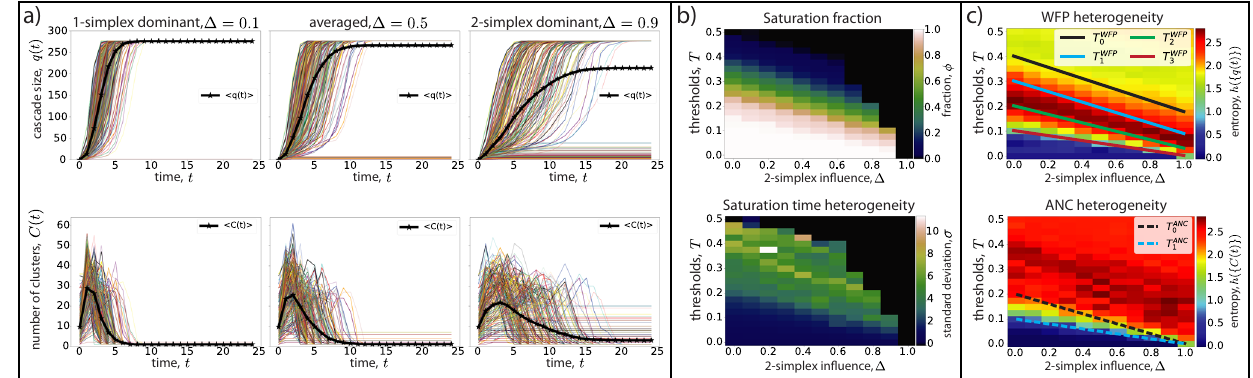
Fig. 4 Higher-order interactions enhance diversity and ef fi ciency for simplicial threshold model cascade patterns on a C. elegans neuronal complex. a Cascade size q ( t ) (top) and the number C ( t ) of spatially disjoint clusters (bottom) versus time t for 2D simplicial threshold model (STM) cascades with threshold T = 0.1 and Δ ∈ {0.1, 0.5, 0.9}. Different curves represent different initial conditions, and black curves give their means. b For STM cascades with different T and Δ , colors indicate (top) the fraction ϕ of initial conditions in which a cascade saturates the neuronal complex (i.e., spreads everywhere) and (bottom) the standard deviation σ of the times at which saturations occur. Black regions indicate ( T , Δ ) values for which no cascades saturate the network. Cascades are most heterogeneous when T and Δ are neither too small or large. c Colors indicate the heterogeneity of wavefront propagation (WFP) and appearance of new clusters (ANC) properties by showing (top) h ({ q ( t )}) and (bottom) h ({ C ( t )}), where h ( ⋅ ) denotes the discrete Shannon entropy of a set of cascades with different initial conditions (see Methods section “ Entropy calculation ” ). We focus on time t = 5, since these measures are most re fl ective of WFP and ANC at early times. Lines indicate bifurcation theory that we will develop for STM cascades over noisy ring lattices, but as can be seen, the theory is also qualitatively predictive for this neuronal complex. Observe that increasing Δ causes the spatio-temporal patterns' changes (i.e., bifurcations) to occur for smaller T values, which lowers the energy consumption per neuron